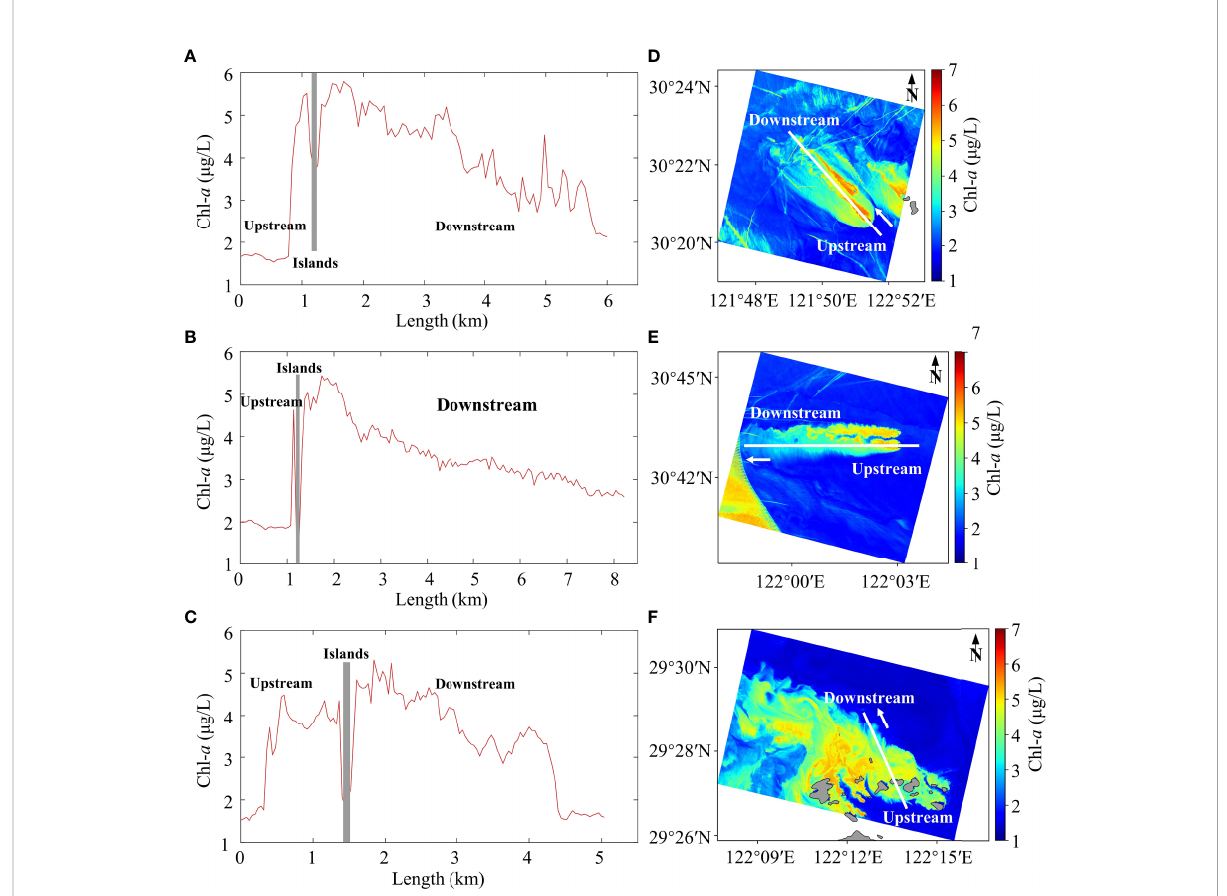
FIGURE 6 The variation in Chl- a concentrations upstream and downstream of the islands. (A-C) Chl- a concentration variation trends upstream and downstream of the islands on the white line transect; (D-F) Chl- a concentration distribution in waters adjacent to islands. Grey vertical bars: